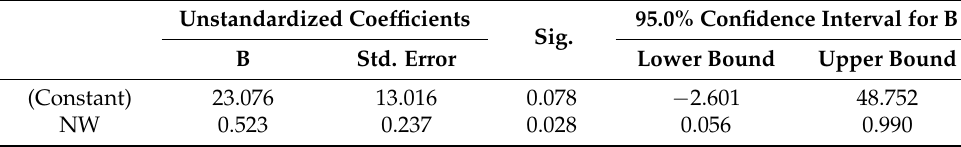
Table 8. Nursing activities score (NAS) simple linear regression model and